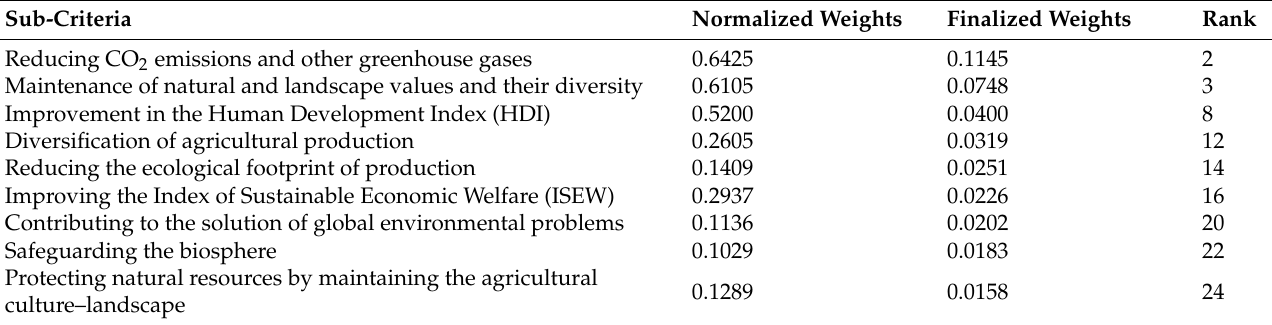
Table 12. The relative importance of different environment-related sub-criteria, ordered by the ascending rank order of sub-criteria.